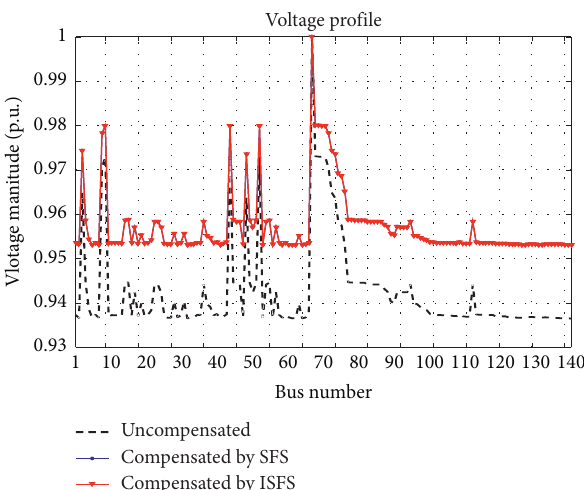
Figure 26: Bus voltage profile of 152-bus network with 100% loading in scenario 1 after compensation.